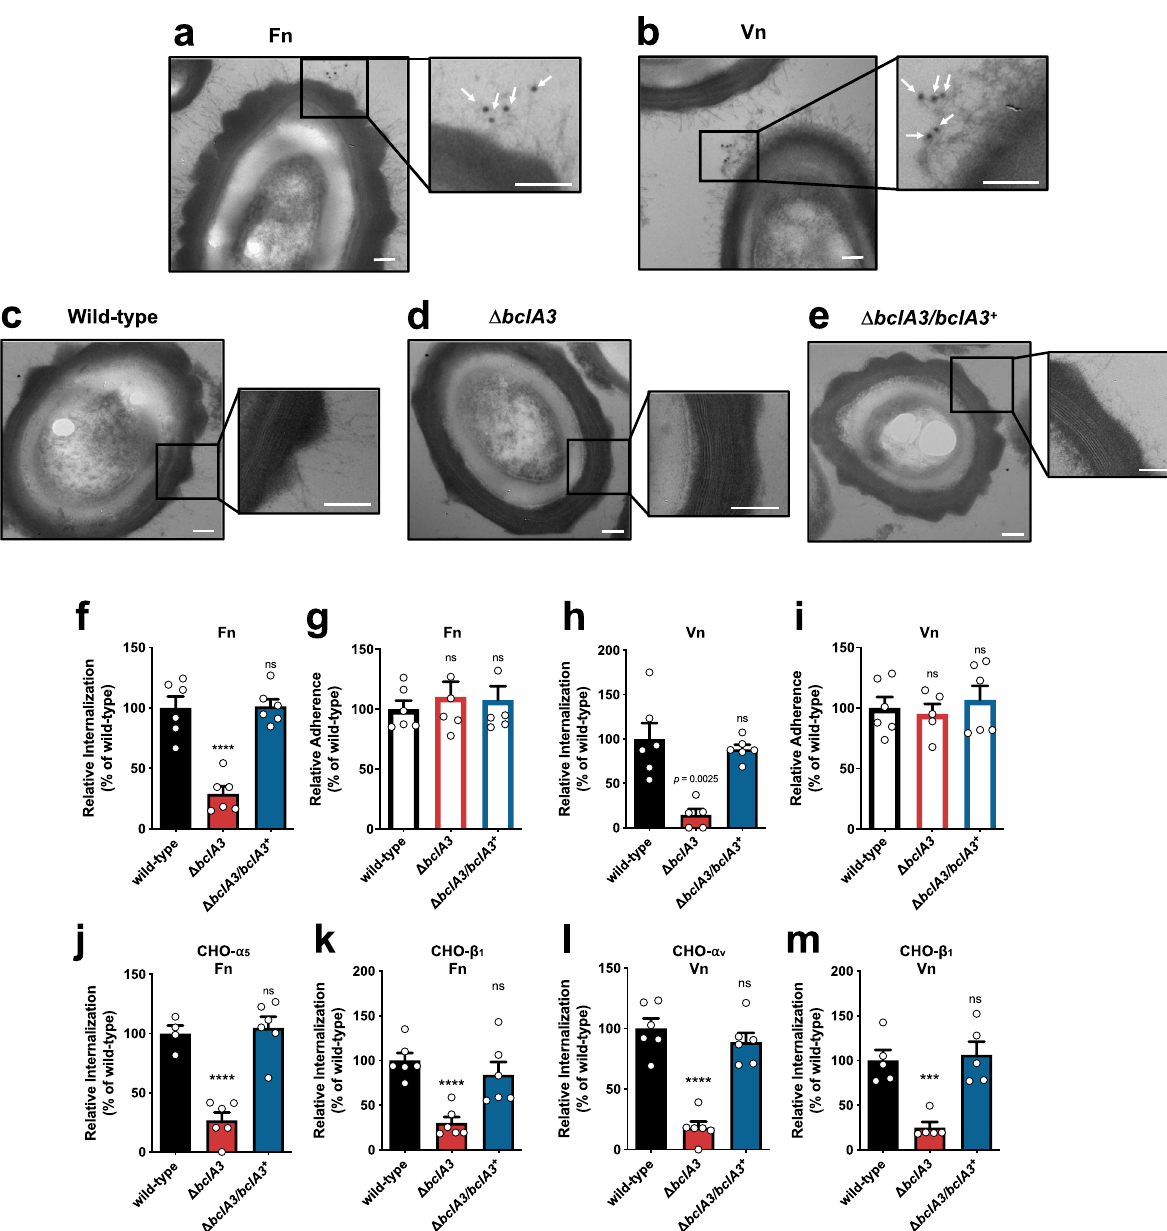
Fig. 5 The collagen-like exosporium protein BclA3 is required for spore entry into intestinal epithelial cells via Fn- α 5 β 1 and Vn- α v β 1 . a , b C. dif fi cile spores R20291 were incubated with Fn or Vn for 1h. Samples were processed and visualized for TEM. White arrows indicate anti-Fn or -Vn rabbit antibody and anti-rabbit-gold 12nm antibody complex. c – e TEM of wild type ( Δ pyrE / pyrE + ), Δ bclA3 , and Δ bclA3/bclA3 + C. dif fi cile R20291 spores. f , h Internalization and g , i adherence in differentiated Caco-2 cells of wild type, Δ bclA3 , and Δ bclA3/bclA3 + C. dif fi cile spores preincubated with f , g Fn or h , i Vn. j , l Internalization and k , m adherence in CHO cells ectopically expressing: j α 5 ; k , m β 1 ; or l α v infected with wild type, Δ bclA3 , and Δ bclA3/bclA3 + C. dif fi cile spores preincubated with j , k Fn or l , m Vn. Data shows internalization and adherence normalized to wild-type spores. In bars, each dot represents one independent well from three independent experiments. Error bars indicate the mean±S.E.M. Statistical analysis was performed by two-tailed unpaired Student ’ s t test, ns, p >0.05; *** p < 0.001; **** p <0.0001. a − e Scale bar,